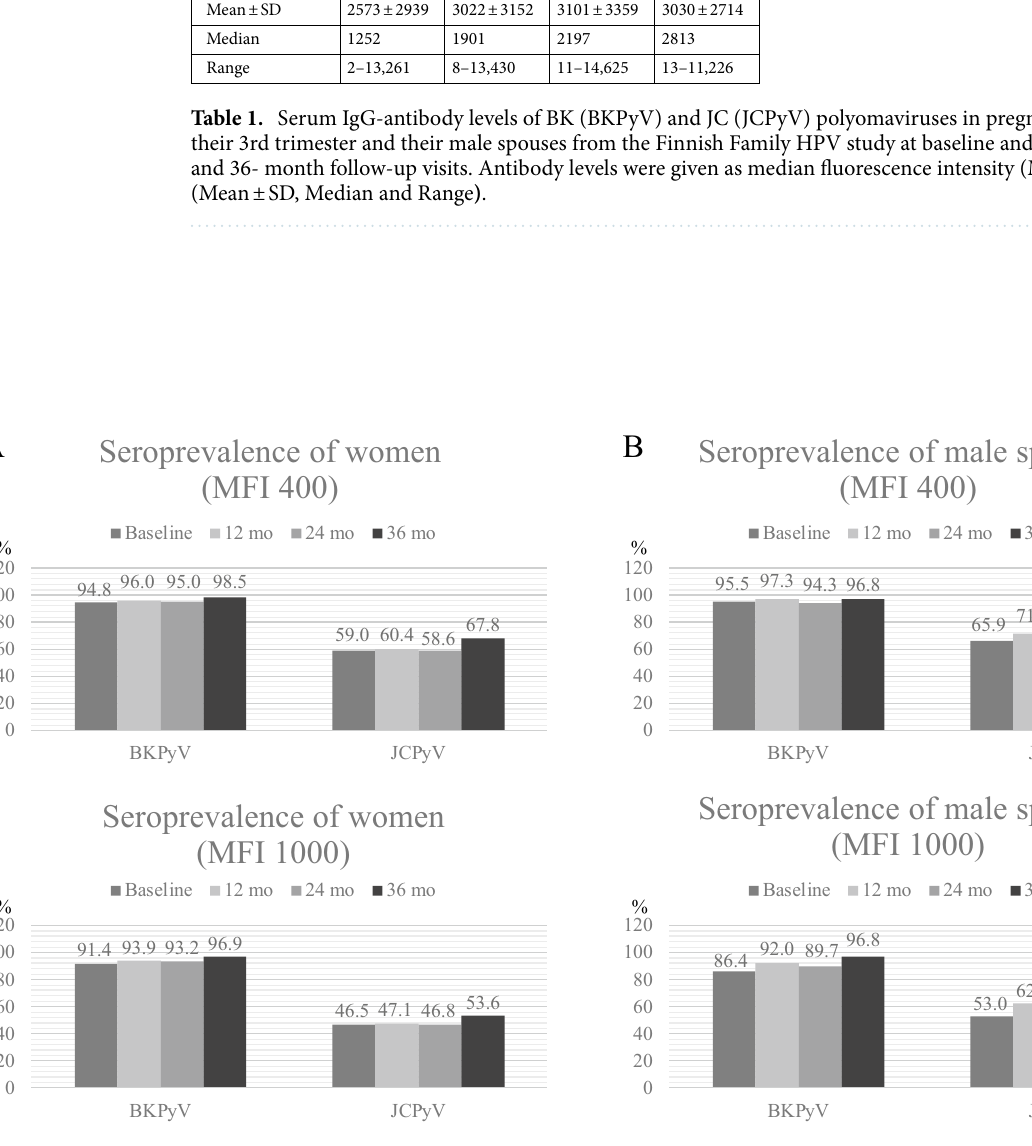
Figure 1. Seroprevalence (%) of BK (BKPyV) and JC (JCPyV) polyomaviruses among women ( A ) and their male spouses ( B ) at baseline (women at 3rd trimester pregnancy) and during the follow up at 12-, 24-, and 36-month visits. Upper panels show the seropositivity of BKPyV and JCPyV using MFI 400 as cut-off, while the lower panel shows the seroprevalences with the more stringent cut –off, MFI